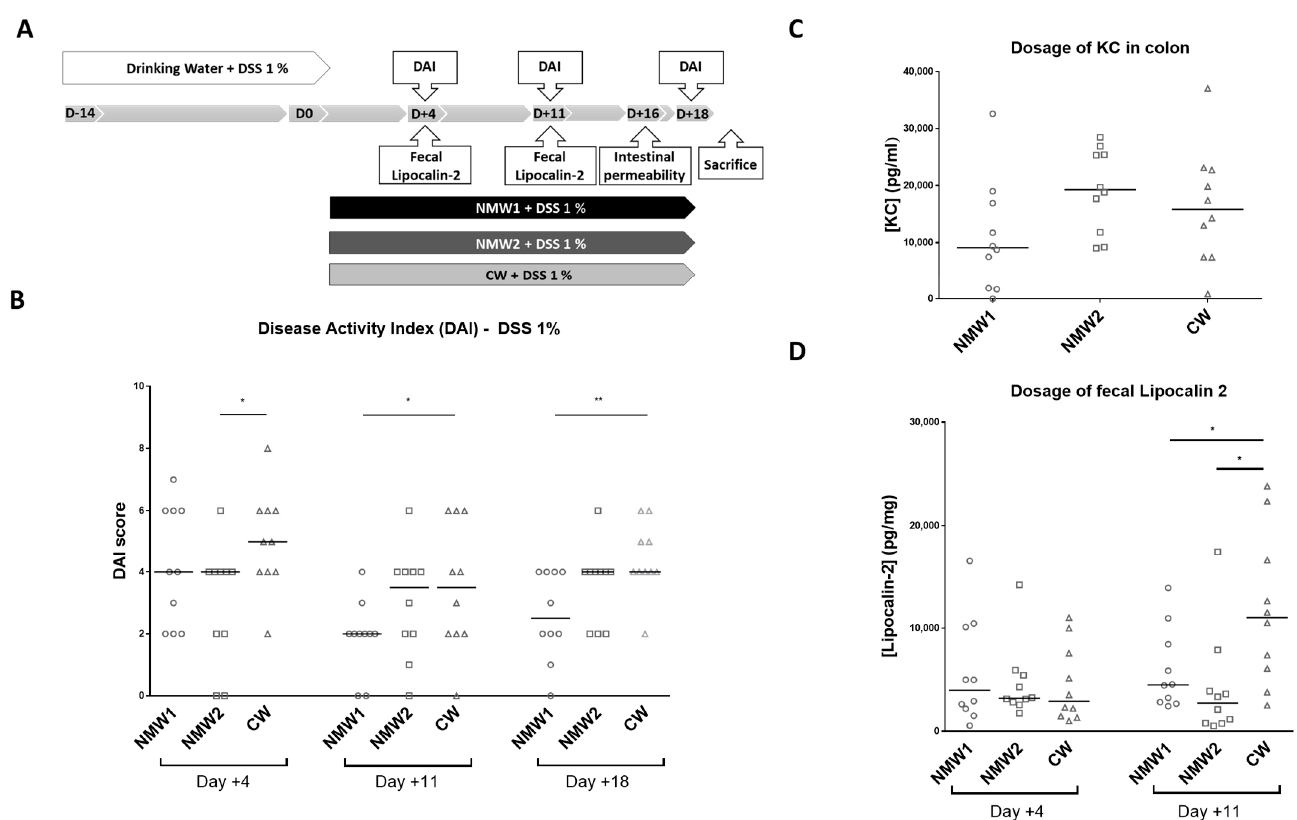
Figure 2. Effect of the administration of NMW1 or NMW2 on a DSS-induced inflammation model. ( A ) Experimental protocol. ( B ) Evaluation of the disease activity index (DAI) on days 4, 11, and 18. ( C ) Production of the proinflammatory cytokine KC by the colonic mucosa. ( D ) Determination of fecal lipocalin-2 levels. The results are presented as the median. Statistical comparisons were carried out after normality testing using Kolmogorov–Smirnov tests, and subsequent one-way ANOVA with the Bonferroni post hoc test was performed (* p < 0.05, ** p < 0.01).